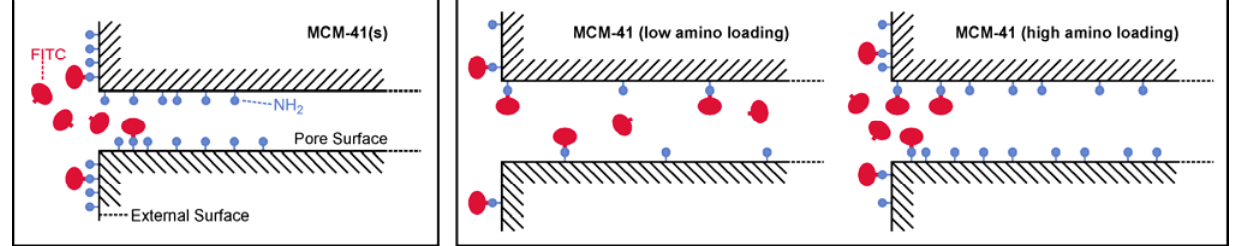
Figure 4. Schematic snapshots illustrating the reaction of FITC with amino-functionalized MCM-41(s) and